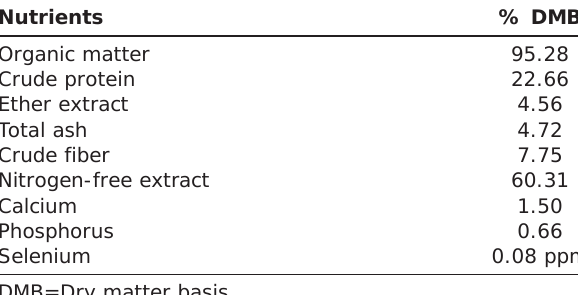
Table-1: Chemical composition of the basal diet offered to male Wistar rats.